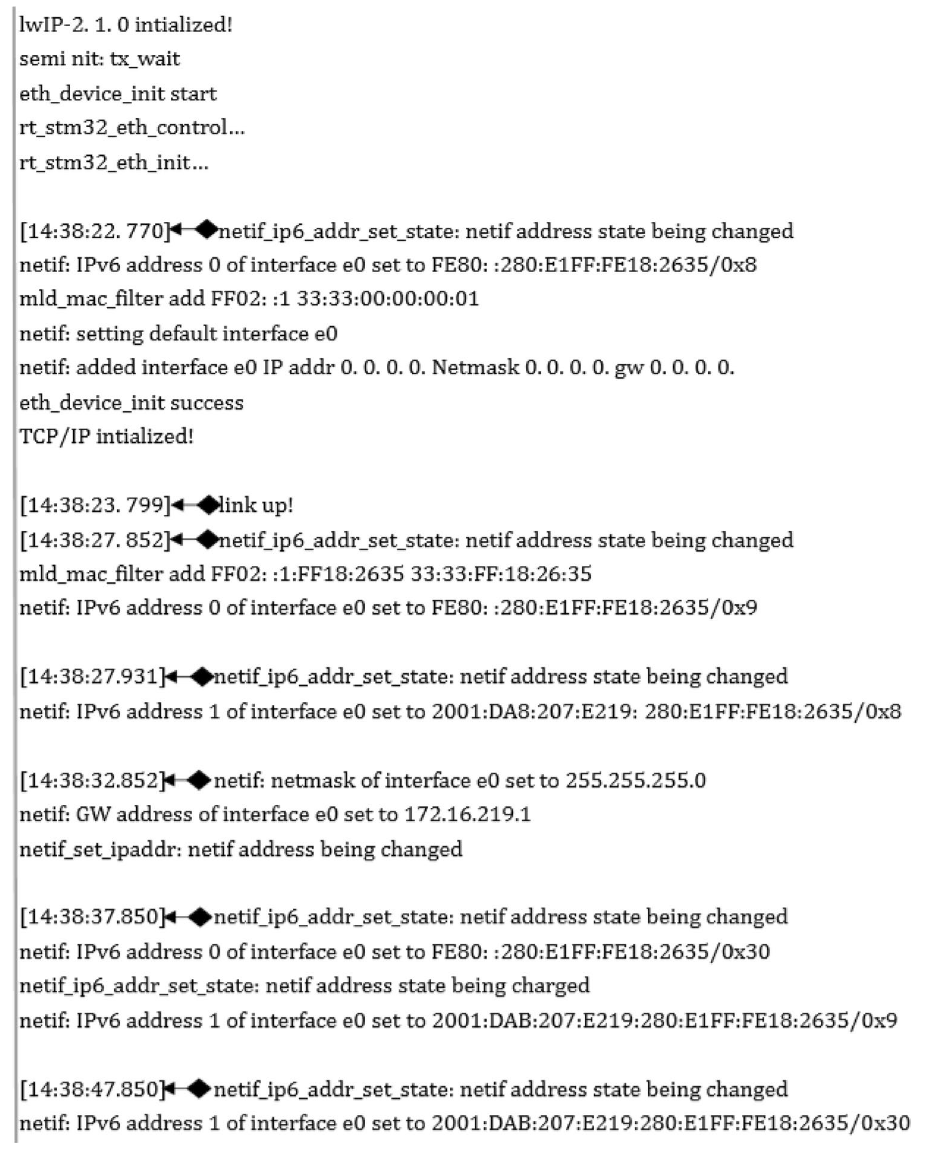
Figure 13. Output Information for system debugging from the serial